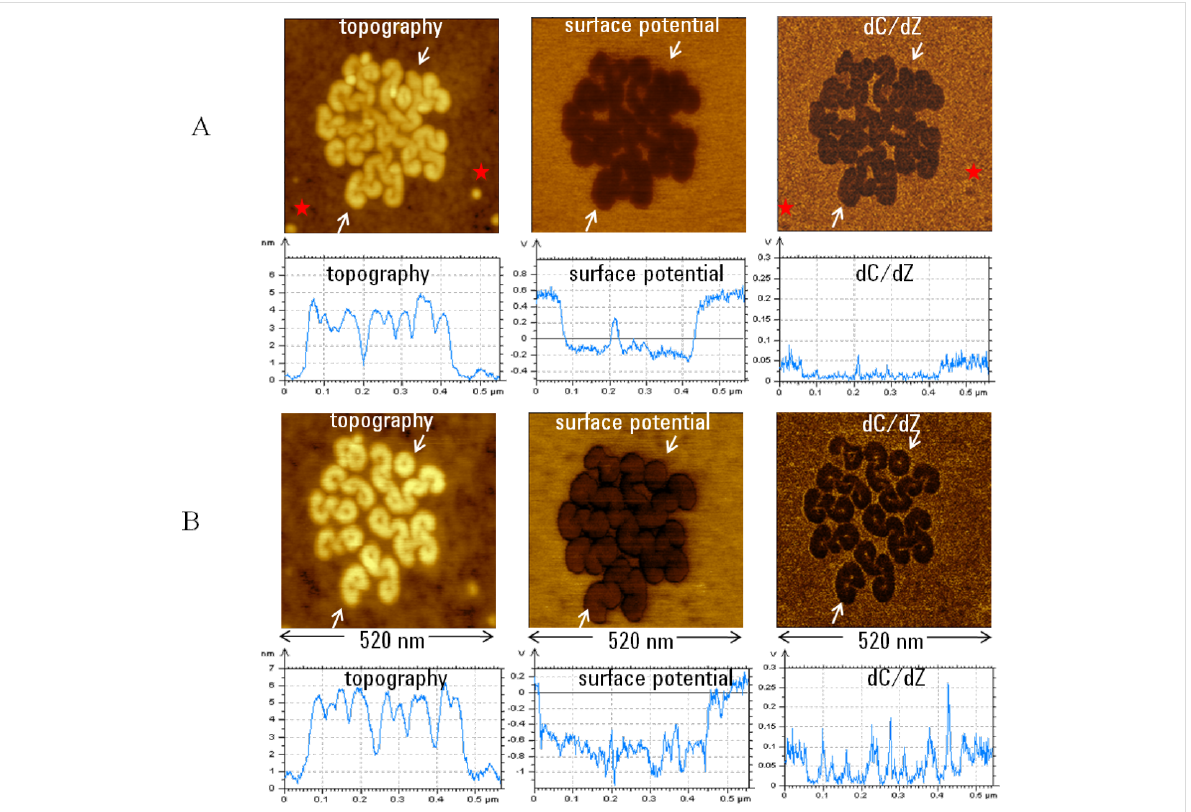
Figure 4: Topography, surface potential and d C /d Z images and cross-section plots obtained on a domain of F 14 H 20 self-assemblies on the Si sub- strate. The plots, which are shown underneath the images, were taken along the directions indicated by the white arrows. The images in A were obtained during imaging in air. Two red stars indicate the contaminating particles, which are not seen in the surface potential image. The images in B were obtained during imaging in methanol vapor.